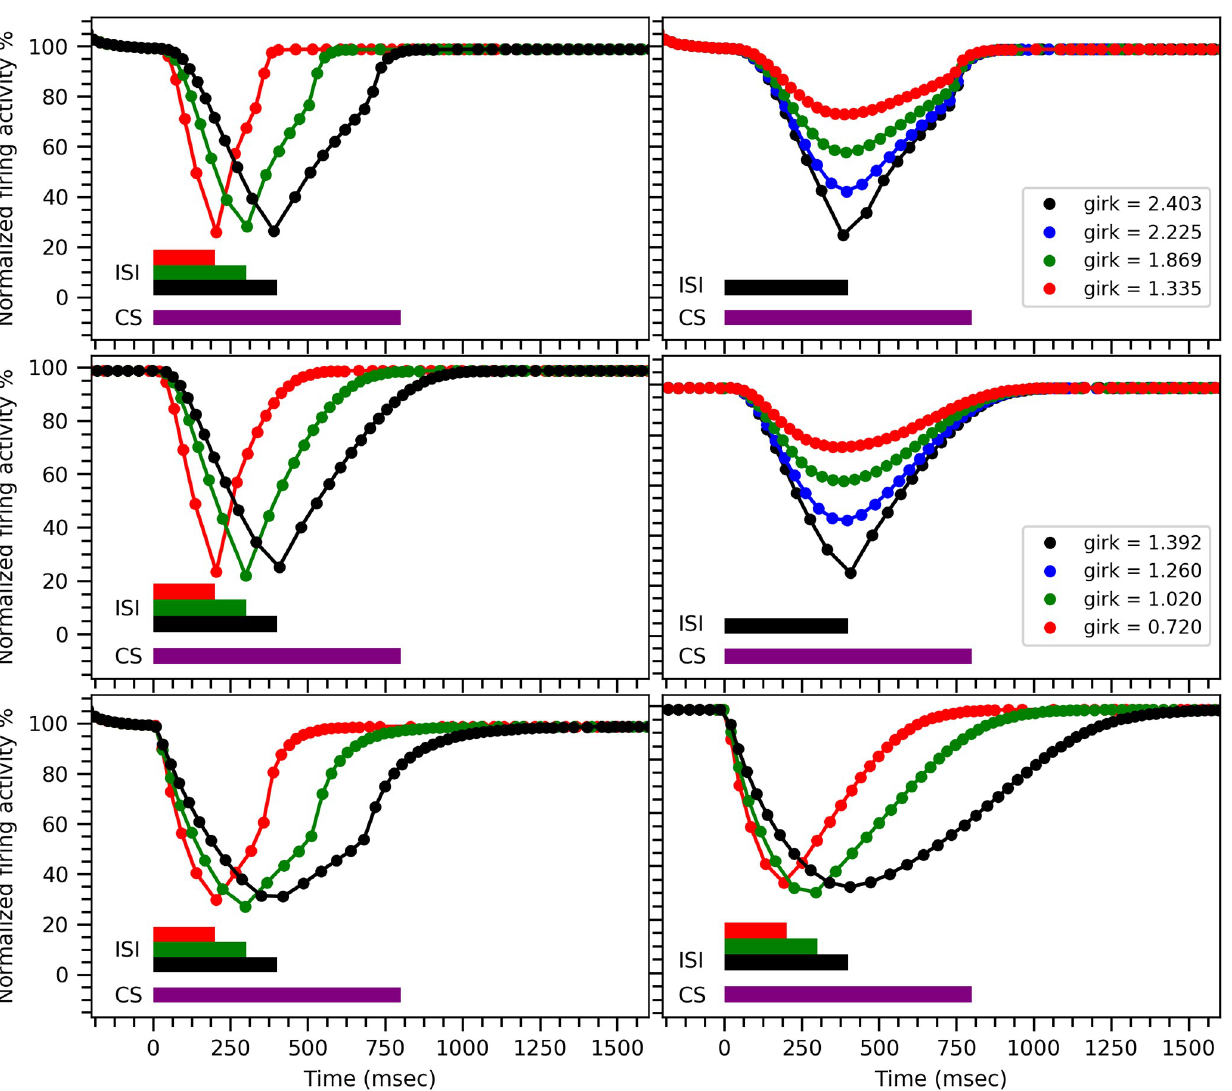
Fig 8. Conditional response profiles for different ISIs and different amounts of MMPIP. Conditional response profiles obtained from the minimal model (top panels) and the comprehensive model (middle panels) for different parameter values (see Table 2, all other parameters as in (Fig 3)) (left panels), and in the presence of the mGluR 7 receptor’s antagonist MMPIP (right panels). As a mGluR 7 antagonist, MMPIP leads to a decrease in the net amount of active mGluR 7 and, hence, the amount of active GIRK ion channels, which corresponds to smaller values of g GIRK (see Eq 2). The bottom panels show the conditional response profile for a modified G-protein subunit dynamics (see text for details) in the minimal model (left panel) and in the comprehensive model (right panel). Note that the normalized instantaneous firing activity is calculated here by taking the inverse of the time interval between two successive spikes, centered on the midpoint between the two spikes, and dividing it by the firing frequency before the onset of the conditional response.